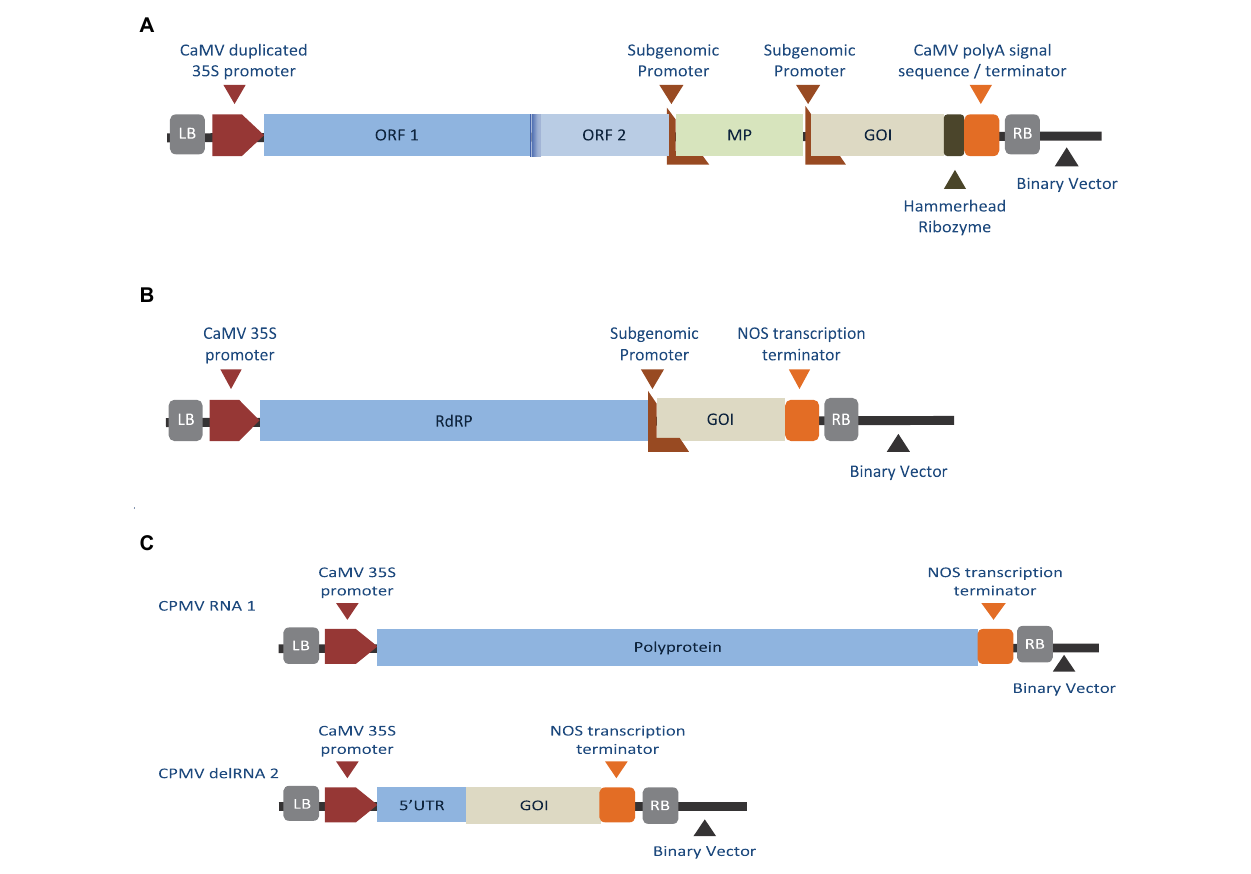
FIGURE 2 | Diagrams showing different replicon-based expression systems. (A) Deconstructed monopartite RNA virus, TMV-based system, where the viral CP was substituted with the GOI under the control of a subgenomic promoter (Lindbo, 2007). (B) Deconstructed monopartite RNA virus, PVX-based system, where the viral CP and MP were substituted with the GOI under the control of a subgenomic promoter (Komarova et al., 2006). (C) Deconstructed bipartite RNA plant virus, CPMV-based system, where the RNA-1 component supplies the viral RdRp, virus genome-linked protein, helicase, and protease, while the modified RNA-2 contains the GOI, replacing those of the viral MP and CP (Cañizares et al., 2006). (A) Described replicon design is capable of replication, cell-to-cell movement, transcription, and replication, while designs (B,C) are capable of all, but deficient in cell-to-cell movement. LB, left border; RB, right border of the T-DNA region. TABLE 2 | Plant-made proteins expressed using deconstructed viral